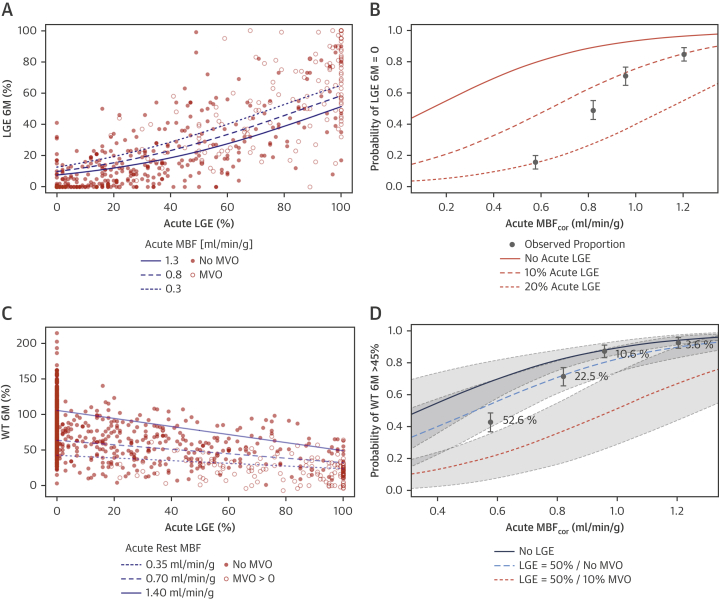
Predictive Value of MBFcor for Final IS and 6M Functional Recovery(A) The lines show the predictions for acute myocardial blood flow corrected (MBFcor) equal to 0.3, 0.8, and 1.3 ml/min/g. (B) The observed proportions of segments with no 6-month (6M) late gadolinium enhancement (LGE) are shown by quartile of acute myocardial blood flow corrected, with 95% confidence intervals. The lines show the prediction for no 6-month late gadolinium enhancement as a function of acute myocardial blood flow corrected and acute late gadolinium enhancement of 0%, 10%, and 20%. (C) The continuous lines show prediction for acute myocardial blood flow corrected equal to 0.35, 0.70, and 1.40 ml/min/g. (D) The observed proportions of segments with wall thickening (WT) <45% are shown by quartile of acute myocardial blood flow corrected, with 95% confidence intervals. The lines show the predictions for wall thickening <45% as a function of acute myocardial blood flow corrected, and 0% and 50% late gadolinium enhancement, and with and without microvascular obstruction in the case of 50% acute late gadolinium enhancement. IS = infarct size.